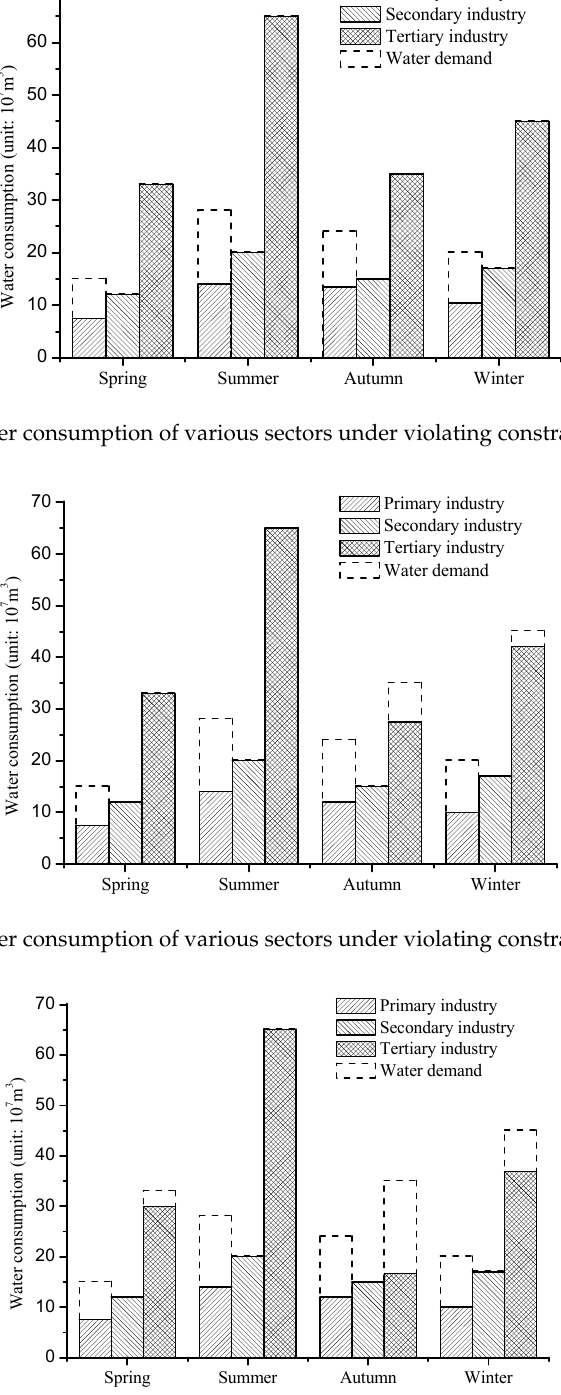
Figure 4. Water consumption of various sectors under violating constraint 0.05 .